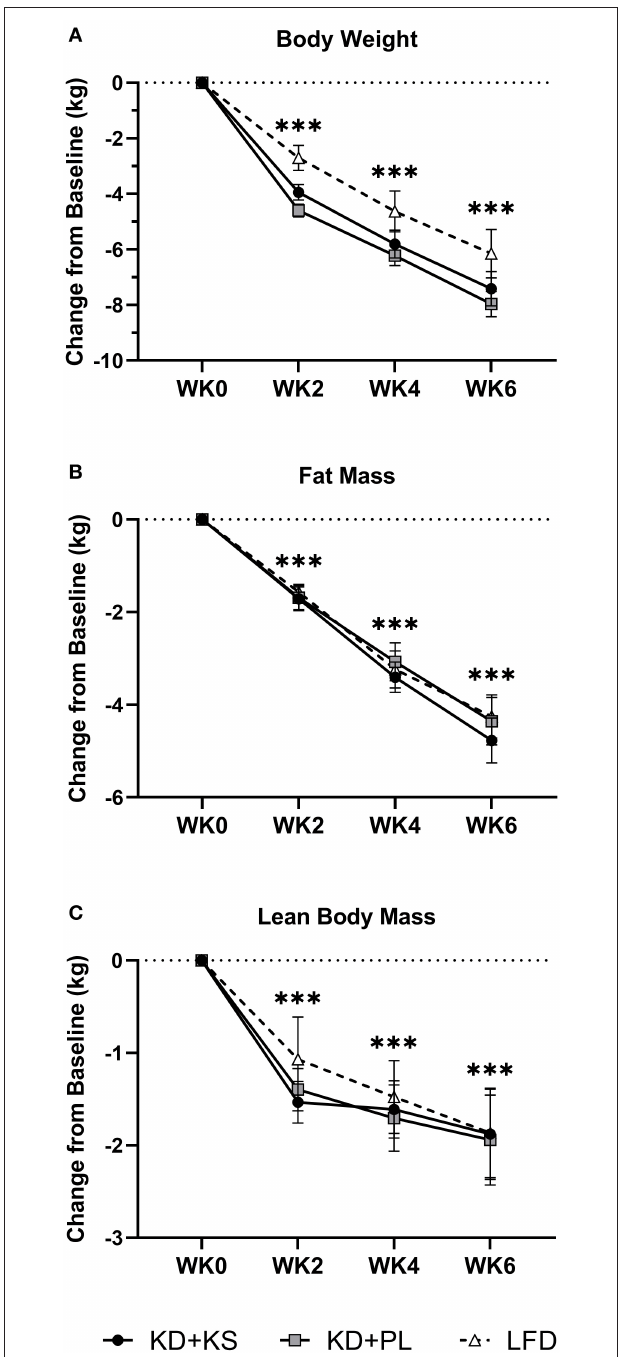
FIGURE 2 | Diet effects on body weight and weight loss composition. Solid lines are primary KD outcomes; dashed lines show LFD for comparison. Results are presented as absolute change ( ± SEM) from baseline. Panels: (A) scale body weight, (B) DXA whole-body fat and (C) DXA whole-body lean mass. Statistics: 2 (group) × 4 (time) ANOVA. Time effects: *** p < 0.001 from WK0. Body weight and fat mass decreased steadily and significantly between each timepoint after WK0 ( p < 0.001). Lean mass decreased significantly by WK2 ( p < 0.001), followed by no other significant reductions thereafter. With LFD included in the secondary 3 (group) × 4 (time) ANOVA analysis – No major changes were detected besides a higher FFM WK2 value compared to WK6 ( p <